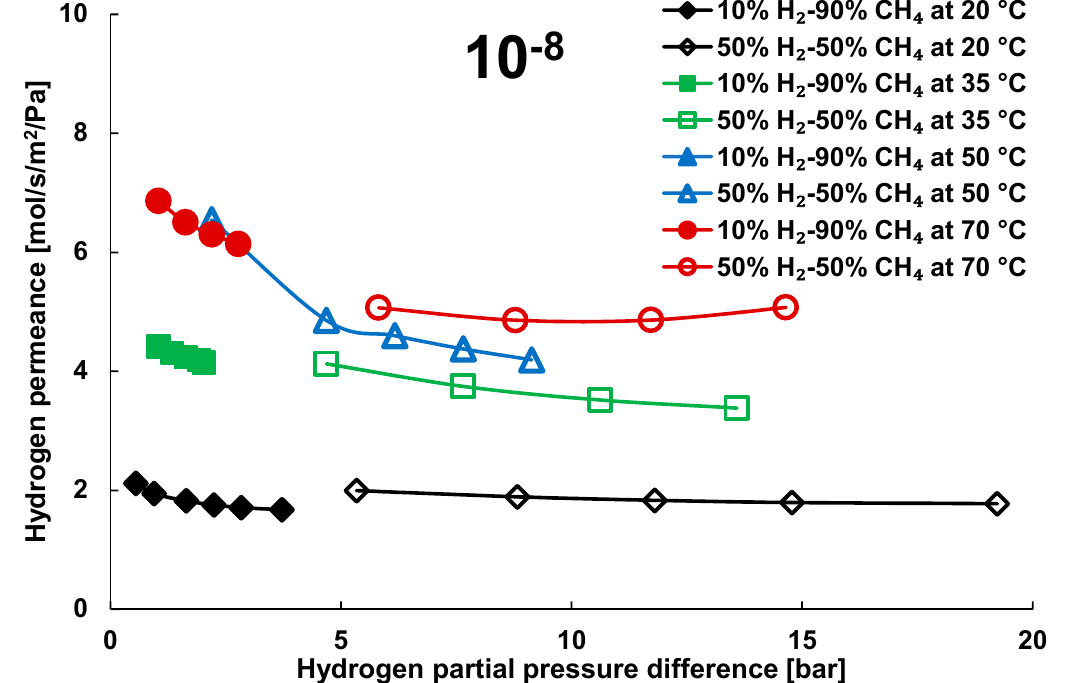
Figure 9. Comparison between permeating hydrogen flow rate in an H 2 -CH 4 mixture with 10% and 50% hydrogen concentration at 20, 35, 50 and 70 °C, for CMSM-550.